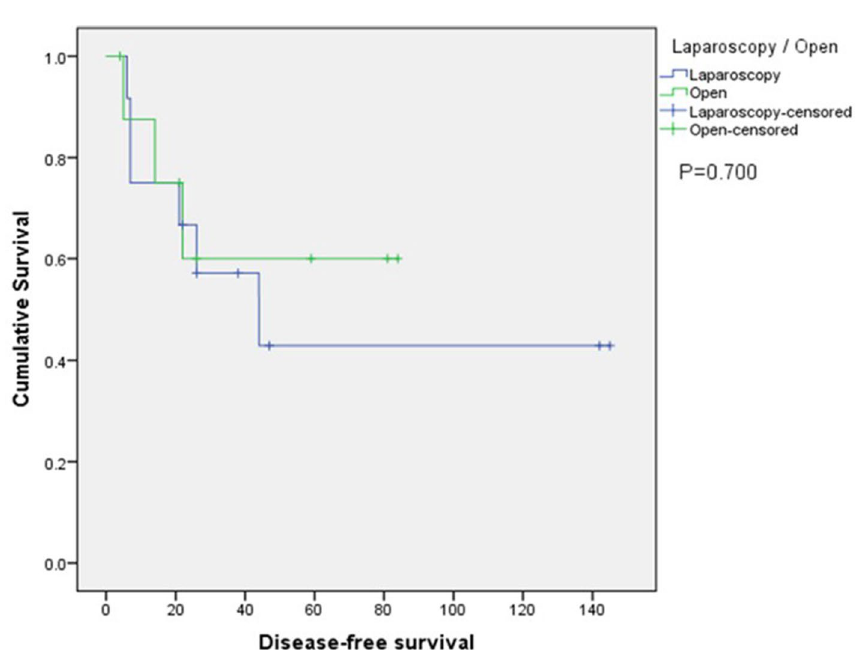
Figure 4. Kaplan–Meier plot of disease-free